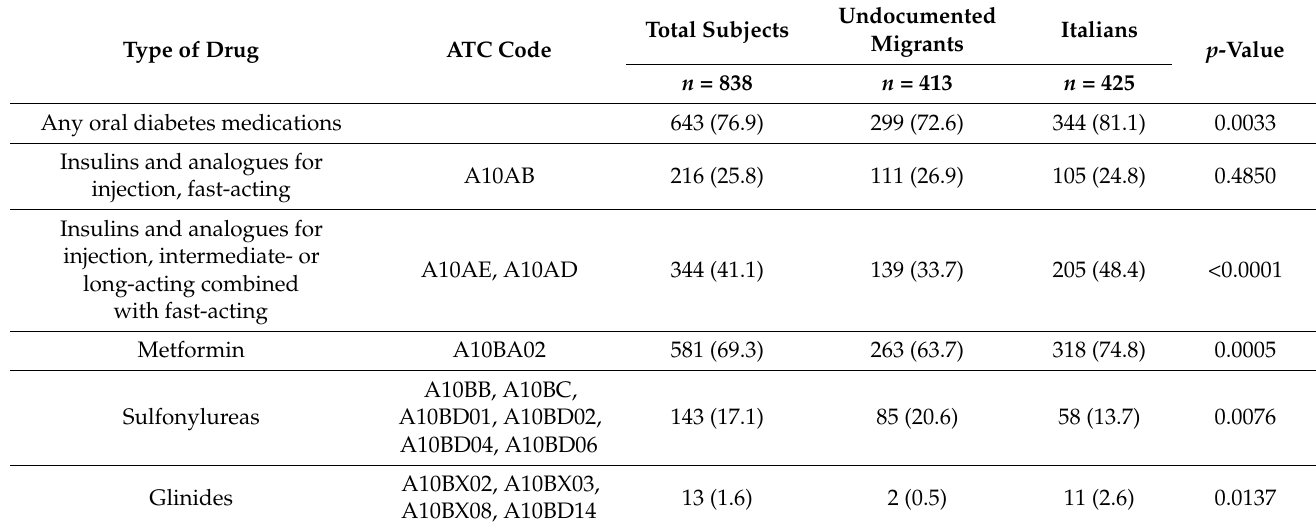
Table 2. T2DM drugs used for undocumented migrants and Italians with